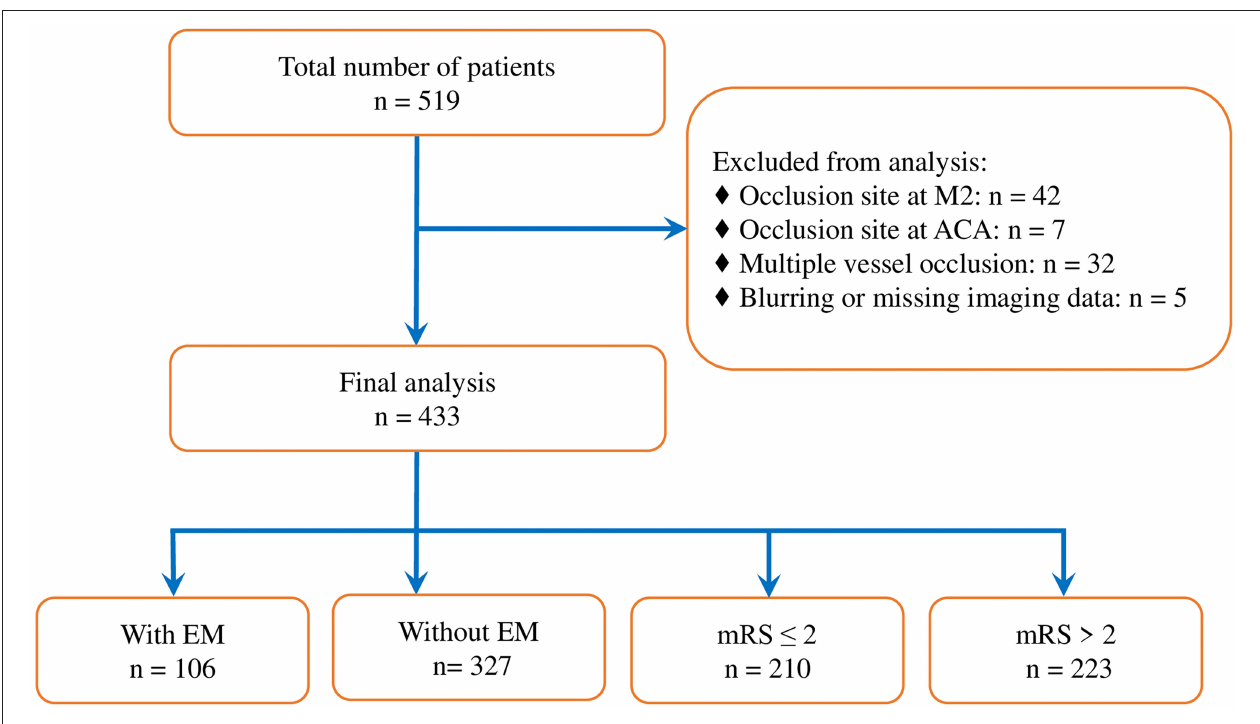
FIGURE 1 | Study flowchart. M2, M2 segment of middle cerebral artery; ACA, anterior cerebral artery; EM, encephalomalacia; and mRS, modified Rankin